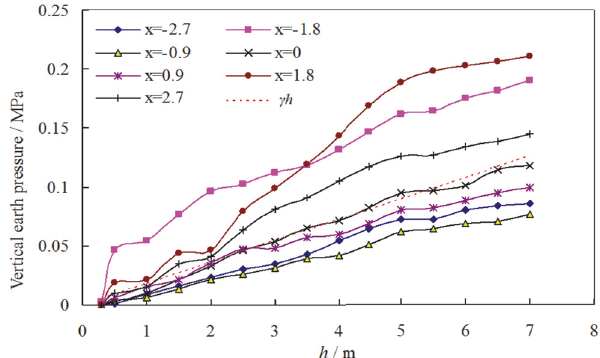
Figure 10: Variation of vertical pressure on the slab on section